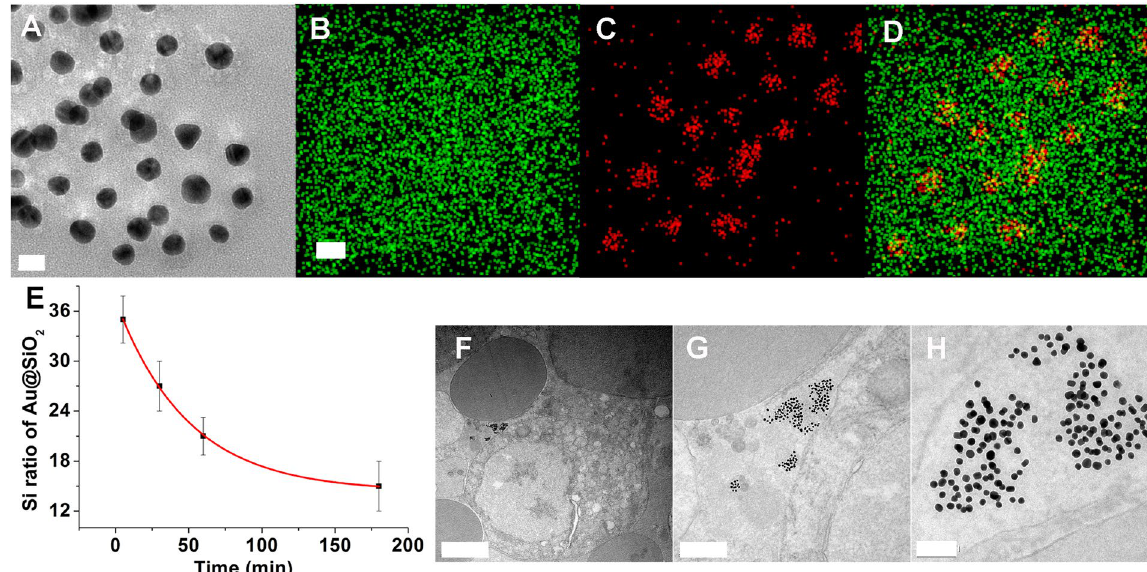
Figure 4. Ex vivo stability of silica in sheep blood. ( A – D ) TEM ( A ) and EDS ( B – D ) images of Au@SiO 2 , incubated in blood for 5 min. Scale bars, 20 nm. ( E ) Plots of the EDS intensity of silicon versus time,